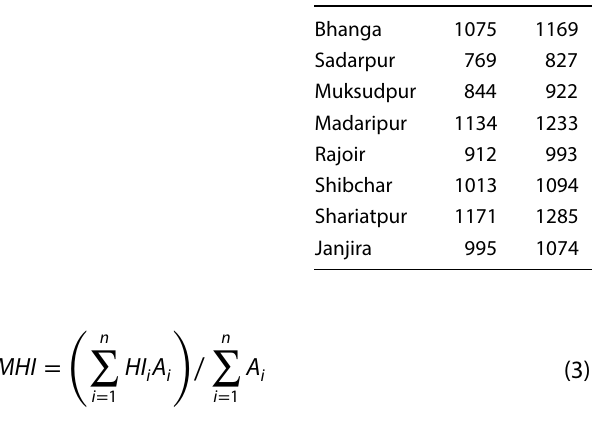
Table 2 Projected mean population density (per km 2 ) under SSP5